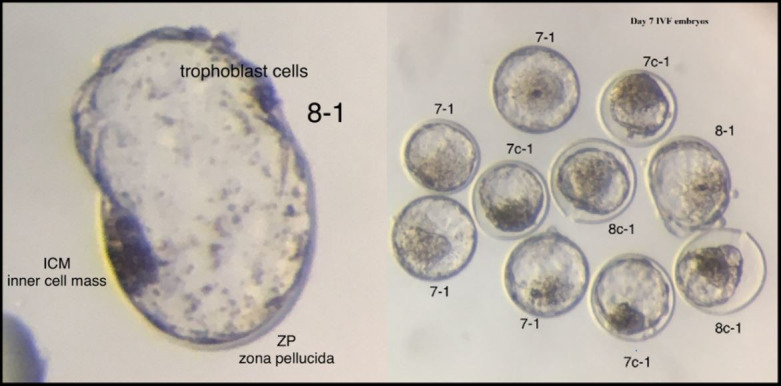
Grade 1 Day 7 IVP Embryos. The first number refers to the stage, 7 (expanded blastocyst), 8 (hatching blastocyst) and c (collapsed), and the second number refers to the grade (ICM – inner cell mass, ZP – zona pellucida).